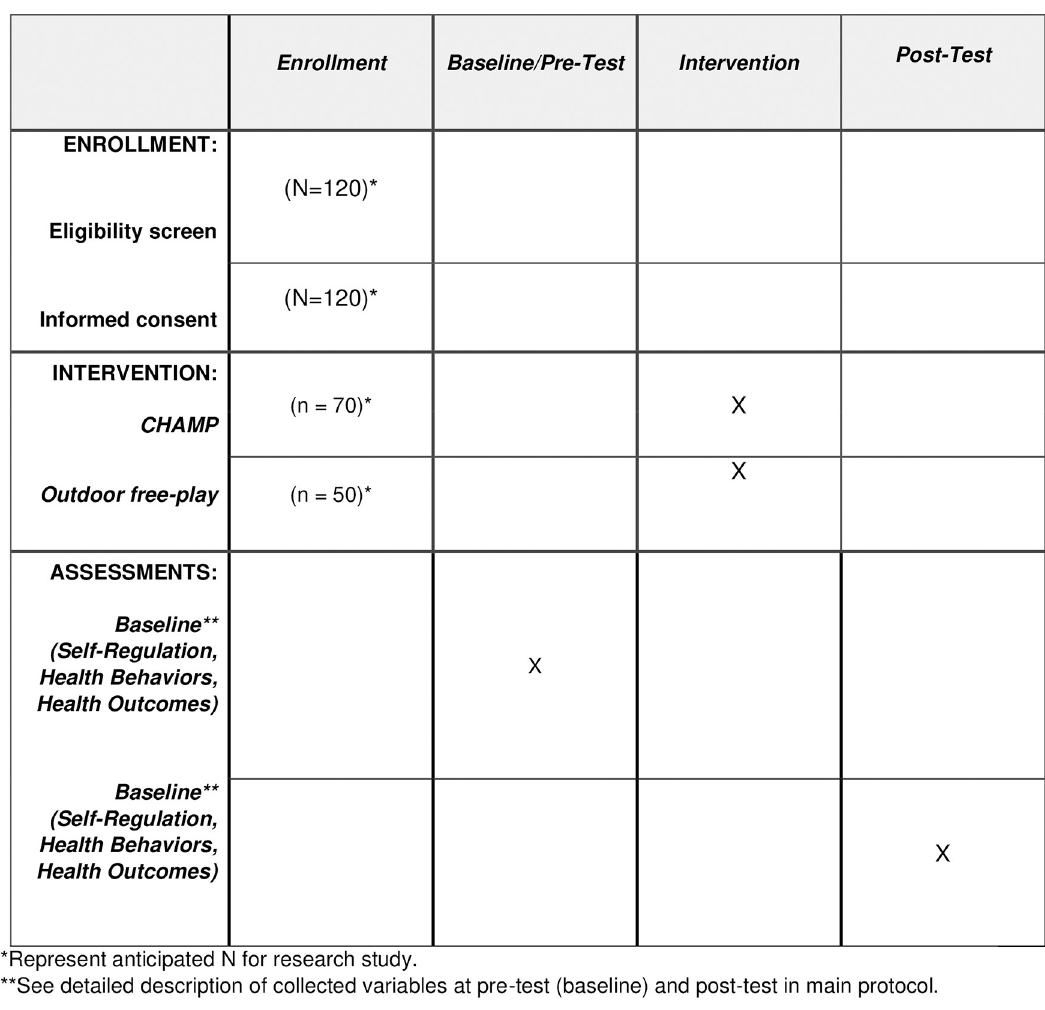
Fig 1. SPIRIT diagram for the schedule of enrollment, interventions, and